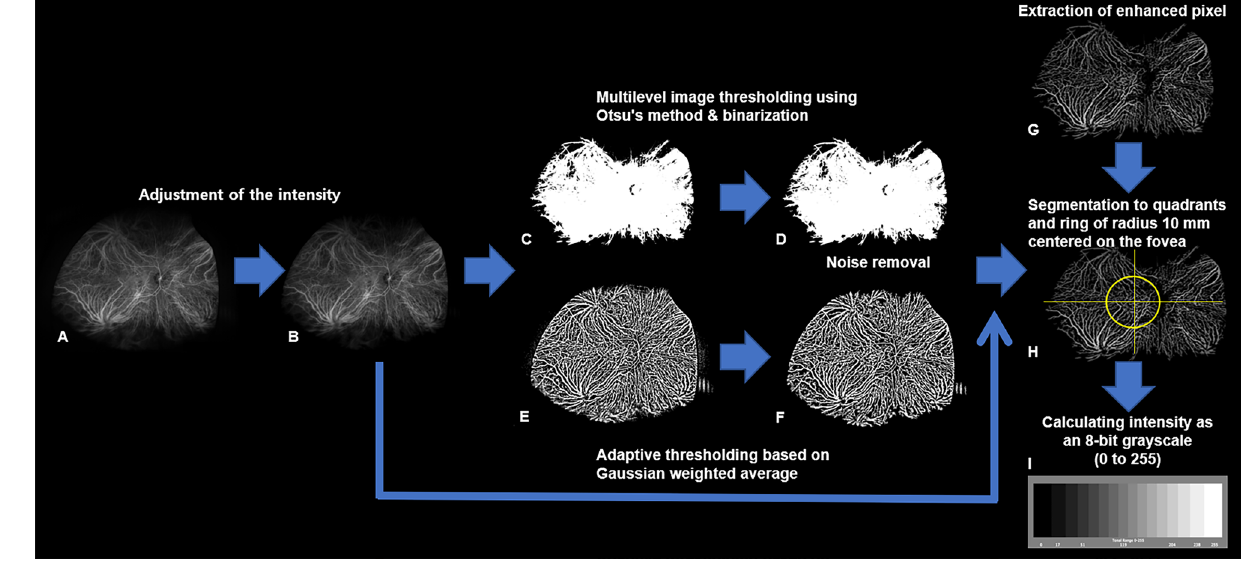
Figure 3. Image processing method mentioned in this study using ImageJ (NIH, USA, http:// rsbweb. nih. gov/ ij/) software. The original image was cropped to remove the background and areas obscured by the eyelashes ( A ). The brightness intensity of the entire image was adjusted so that the average intensity of the blood vessels inside the disc was the same in all images ( B ). Multilevel image thresholding, using Otsu’s method and binarization, was employed to remove non-enhanced pixels ( C , D ). An adaptive threshold method based on the Gaussian-weighted average was applied to extract enhanced pixels ( E , F ). After noise removal ( D ), the image was enhanced ( F , G ). The images were segmented into quadrants within a circle with a radius of 10 mm centered on the fovea ( H ). The brightness intensity of each area was calculated as an 8-bit gray-scale ( I